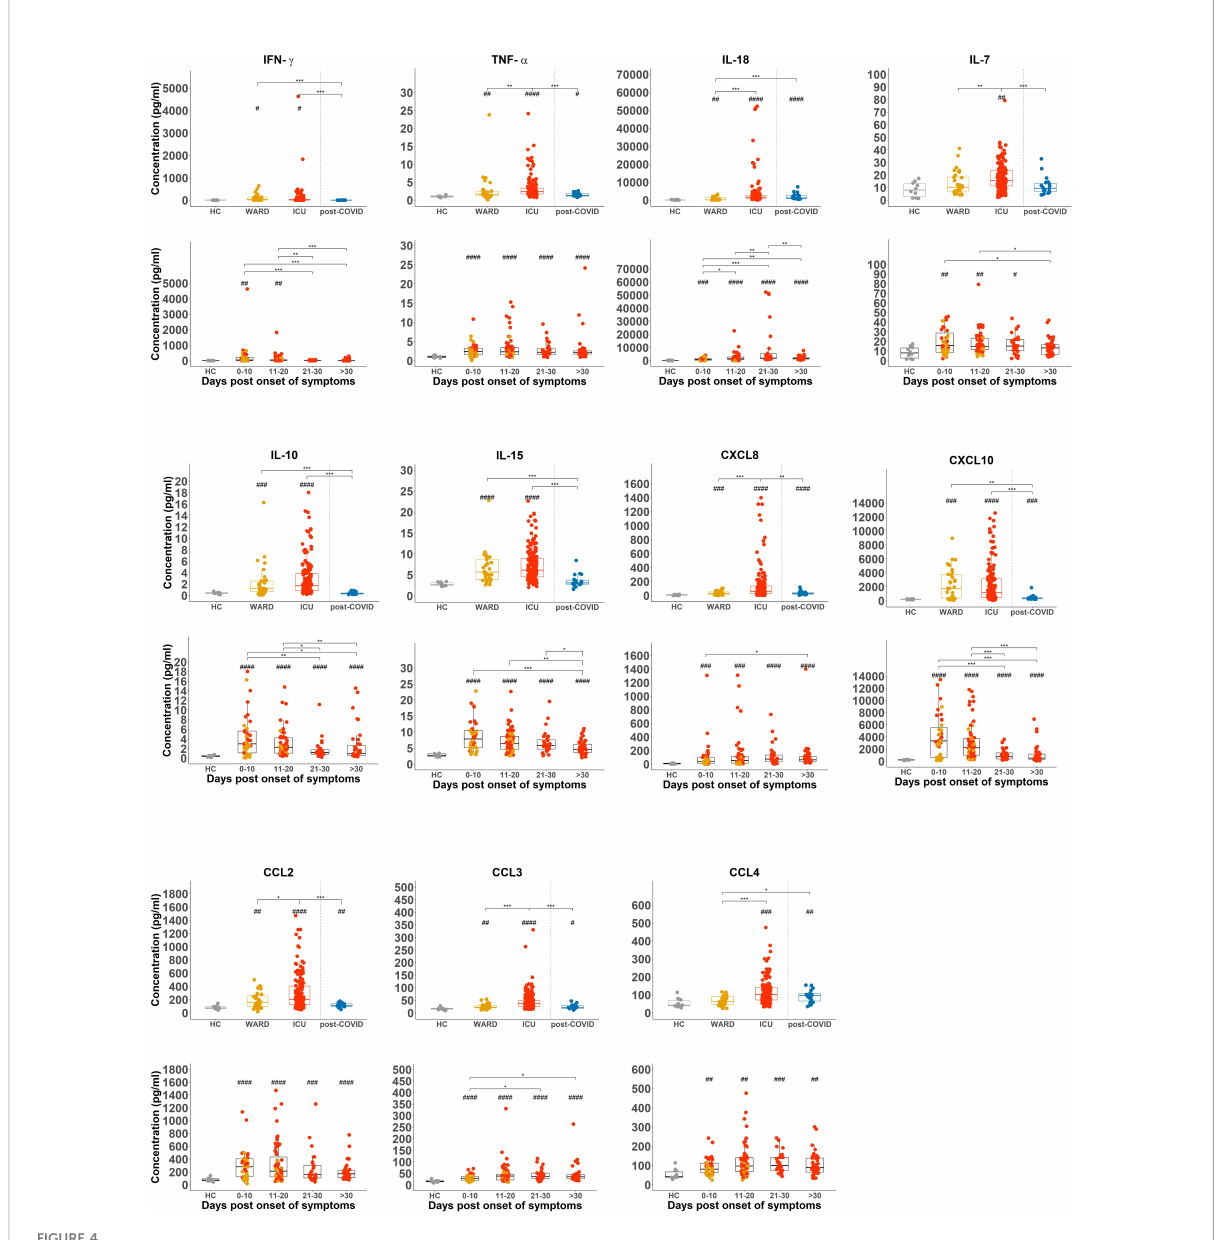
to the hospital six weeks after discharge. Plasma concentrations were measured by MSD (Meso Scale Discovery). Each symbol represents a single patient. For the comparison of groups, p-values were obtained using Wilcoxon signed-rank test with Bonferroni correction. * Represent differences between indicated groups, # represent differences with HCs. */ # p<0.05; **/ ## p<0.01; ***/ ### p<0.001;****/ ####